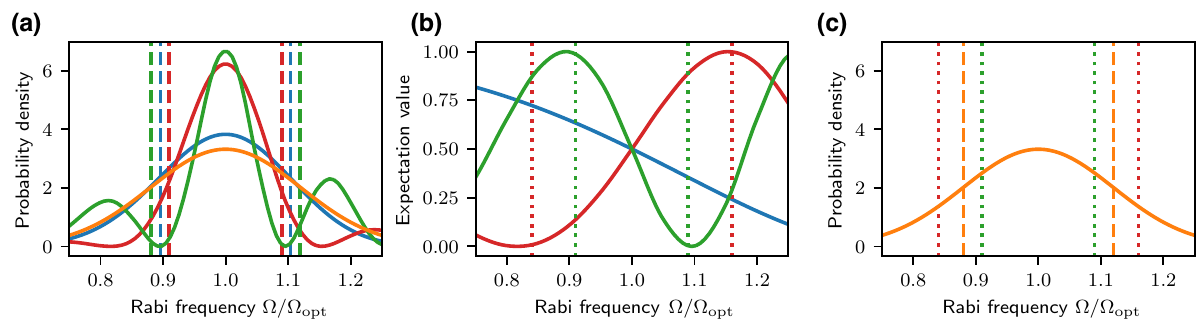
FIG. 7. Illustration of the decision-making process on which gate sequence to use in the next measurements. Plot (a) illustrates the variance minimization strategy for the prior given in orange and the expected posterior probability distributions calculated using the expected outcomes. We compare the standard deviations (dashed lines) of the expected posteriors for each setting under consideration ( N g = 1 blue, N g = 3 red, N g = 5 green with (cid:13)ϕ target = 0) to select the smallest for the next measurement setting. In this example the deviation for three gates is the narrowest and is thus chosen. Plot (b) shows the expected outcome probability P ( | g , g (cid:3) ) for the | g , g (cid:3) state according to the model for each setting ( N = 1 blue, N = 3 red, N = 5 green with (cid:13)ϕ = 0) depending on the Rabi target g g g frequency (cid:8) . In this case the outcome probability for P ( | e , e (cid:3) ) = 1 − P ( | g , g (cid:3) ) with population in the remaining states being zero. The dotted lines show the thresholds used for the thresholded strategy. In (c) these thresholds are used to evaluate the same prior. We only consider the standard deviation of the prior (dashed lines), with the width of the prior being larger than the five-gate threshold (green) but below the three-gate threshold (red), leading to the three-gate setting being chosen. The single gate setting does not have any thresholds, being the fallback option if no other setting passes the